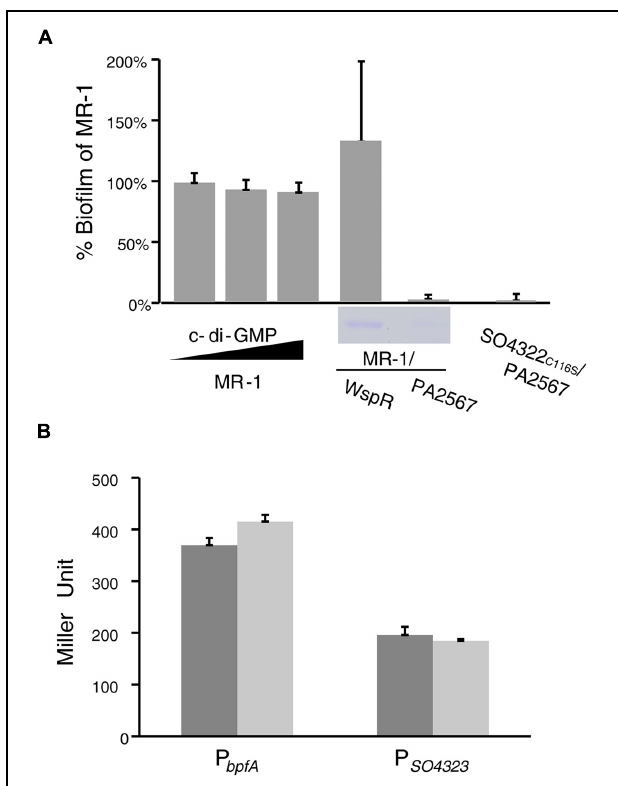
FIGURE 5 | MR-1 biofilm formation requires c-di-GMP but not sensitive to medium phosphate level. (A) A biofilm assay examining MR-1, MR-1/P tac -WspR, MR-1/pHG102-PA2567, and BpfG C116S /pHG102-PA2567. MR-1/P tac -WspR was induced with 0.1 mM IPTG; MR-1 was treated with 0 mM, 60 mM and 120 mM c-di-GMP. BpfA in the supernatant fraction were shown by SDS-PAGE. (B) Promoter activities of bpfA and bpfD in MR-1 (dark) and MR-1/pHG102-PA2567 (light), respectively. The samples were collected in log phase (OD 600 =